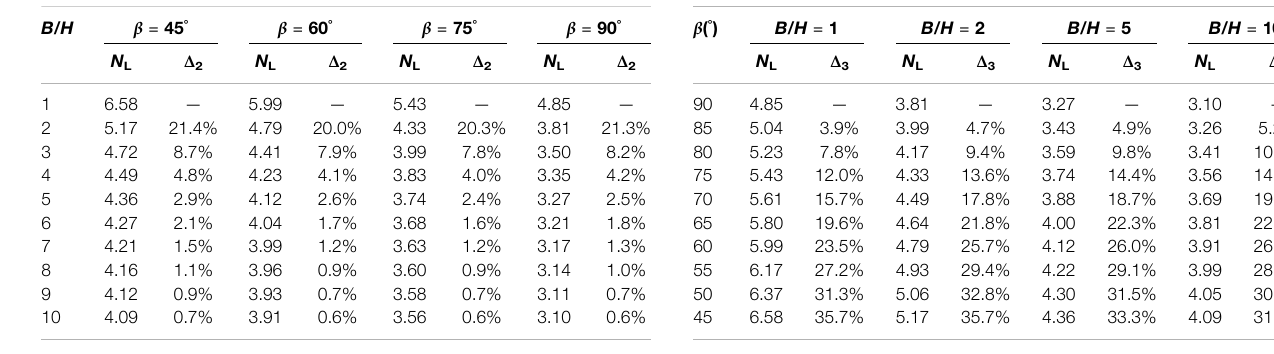
TABLE 3 | Effects of slope angle β on stability factor N L ( k h (cid:1) 0.2, ζ (cid:1)